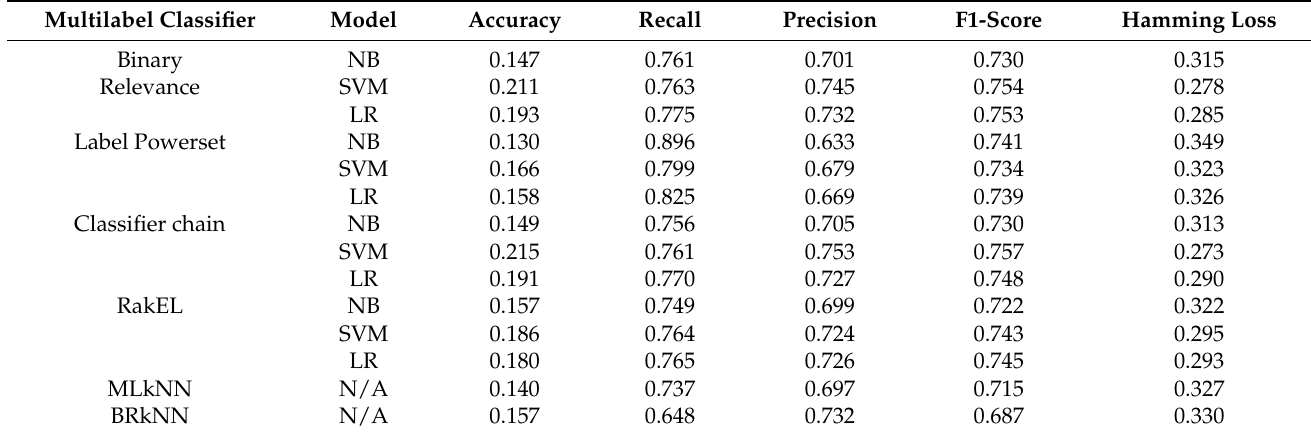
Table 1. Performance of ML models based on 5-fold cross validation.